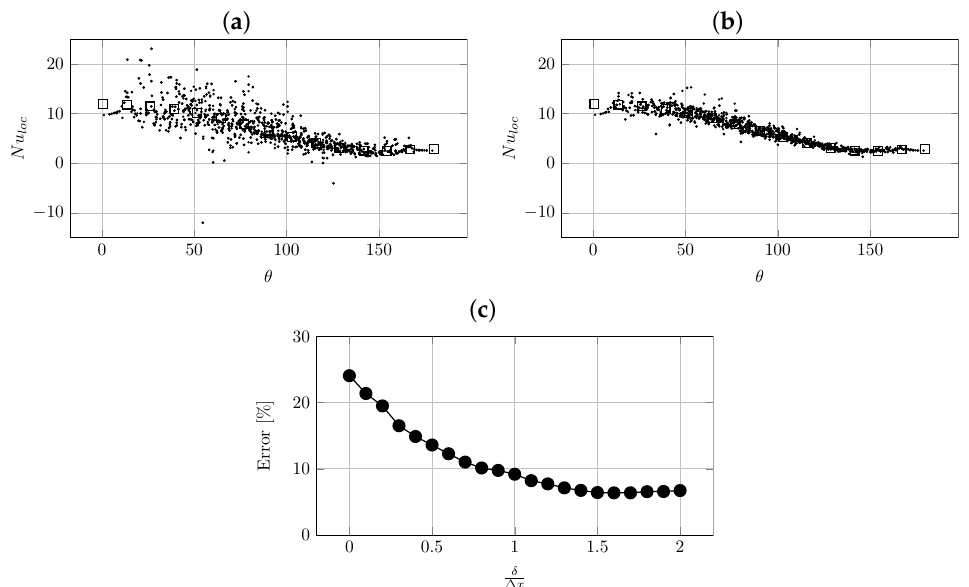
Figure 6. Local Nusselt coefficient for a uniform flow past an isolated sphere at Re = 100, as function of the azimuthal angle θ , for all points on the particle surface (for all β plans) at ( a ) δ = 0 and ( b ) δ = 1: () present work, ( ) Massol [10]. ( c ) is local Nusselt number relative error to Massol’s result [10] as function of the extrapolation distance δ